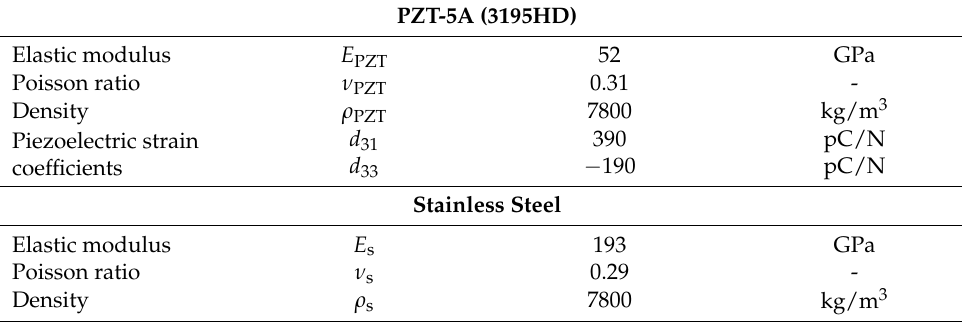
Table 1. Properties of PZT-5A and stainless steel [39].